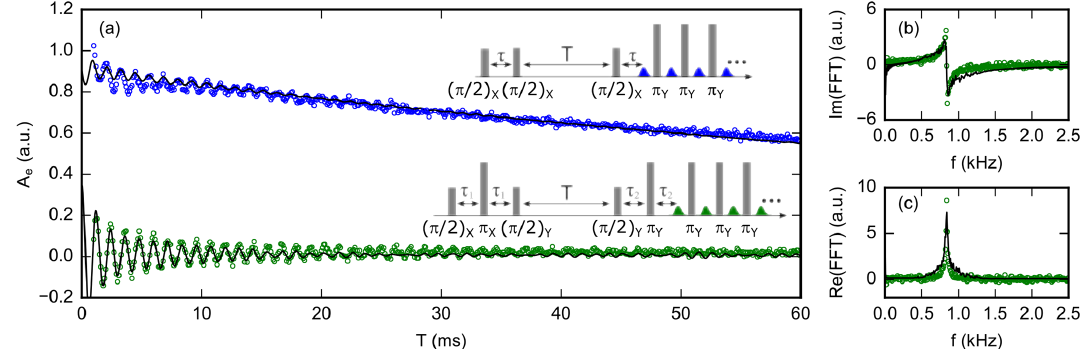
Figure 11. (a) Three-pulse (blue circles) and five-pulse (green circles) ESEEM signals of Bi : Si donors at B 0 = 0 . 1mT. Black lines are simulations assuming a 29 Si concentration of p = 4 . 4 × 10 − 4 . (b) Imaginary and (c) real part of the Fourier transform of the five-pulse ESEEM data. The spectrum only contains a peak at 850Hz, which is the 29 Si nuclei Larmor frequency at this